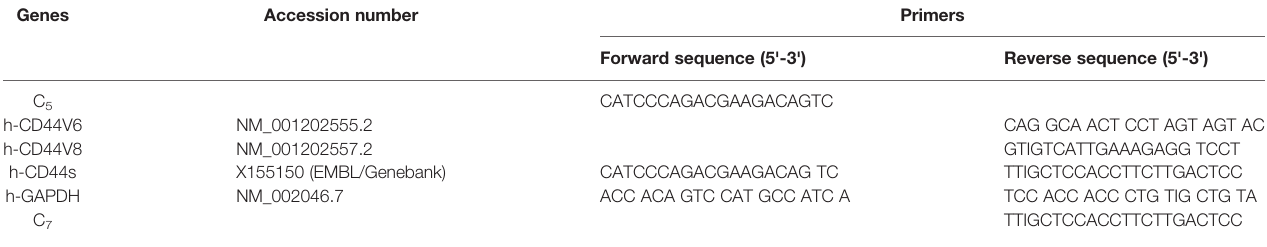
TABLE 2 | CD44 exon speci fi c PCR examined using 3' primers complementary to v6 and vs exons and a primer to the 5' constitutive exon 5.